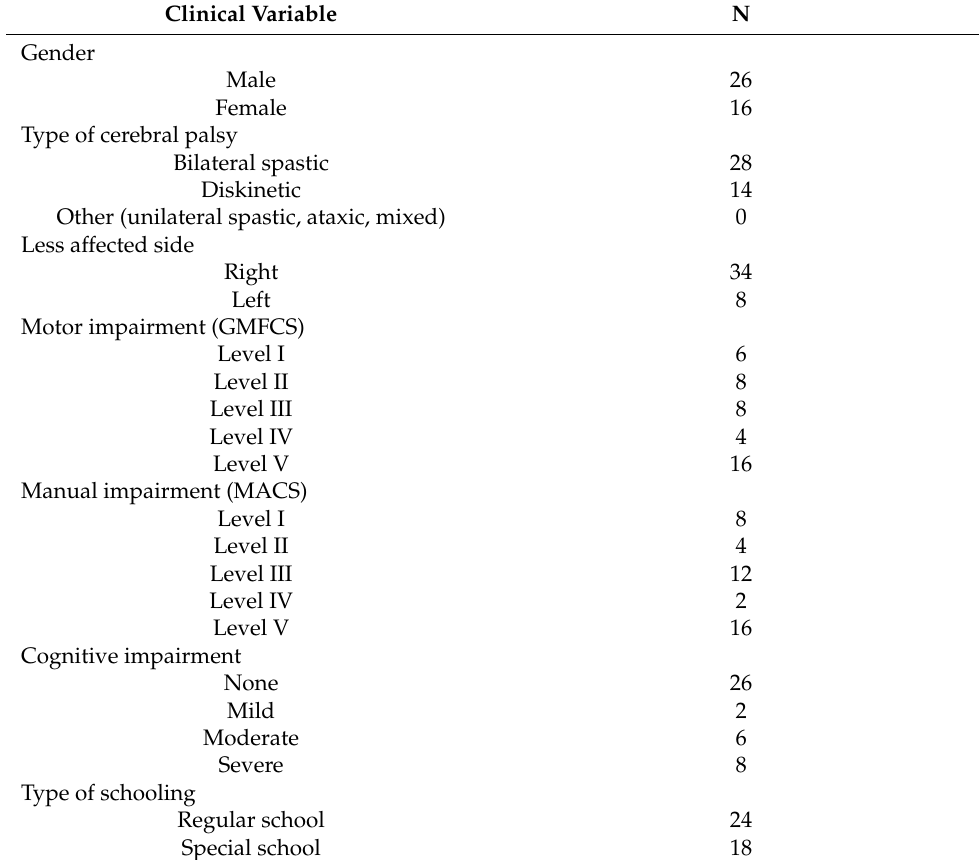
Table 1. Demographic and clinical characteristics of the children and adolescents with cerebral